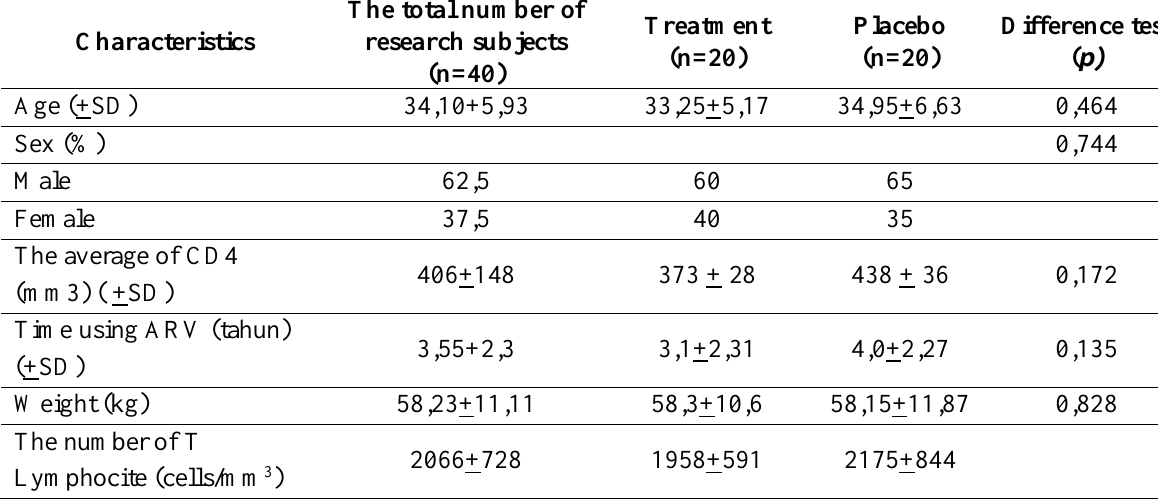
Table 1. Characteristics of Basic Research Subjects